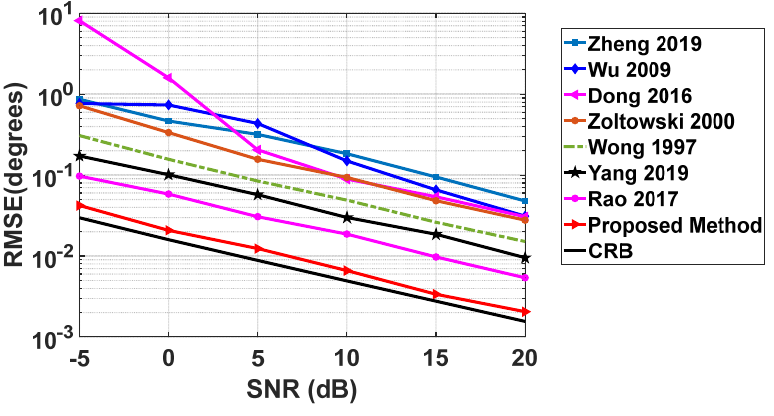
Figure 6. RMSE versus SNR.